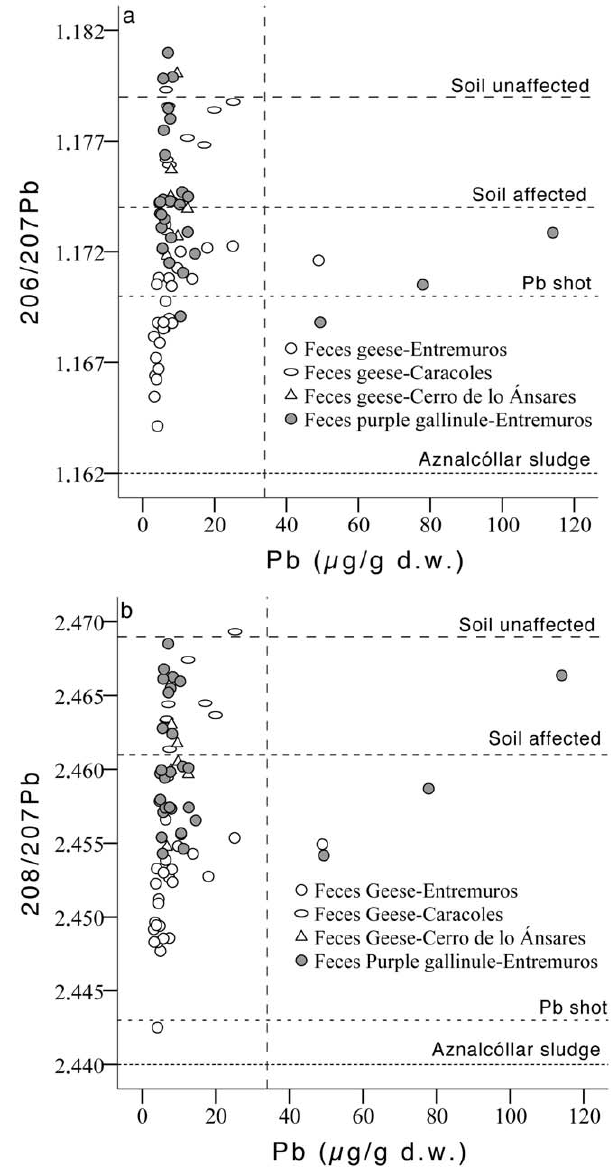
Figure 6. Relationship between fecal Pb concentrations and (a) 206 Pb/ 207 Pb isotope ratios, and (b) 208 Pb/ 207 Pb ratios for feces. The grey vertical dotted line shows the 34 m g/g (dry weight) Pb level. Values above this suggest exposure to point sources of Pb [32,33]. Additionally, the figure shows mean Pb isotopic ratios described for the Aznalco´llar sludge material, for Entremuros sediment affected by the spill, for unaffected sediment adjacent to the Entremuros [23], and for Spanish Pb shot